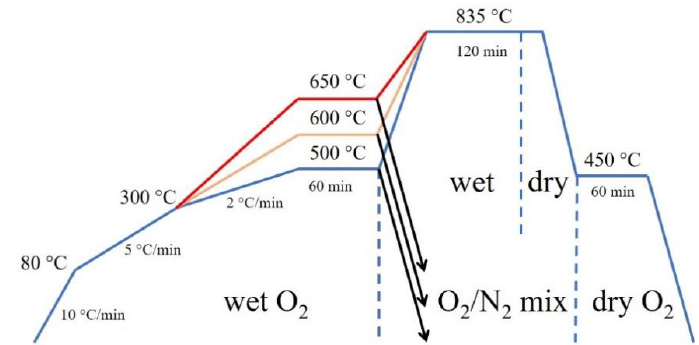
Figure 1. The heat treatment profiles of the YBCO films with different holding temperatures from 500 to 650 °C at the pyrolysis step.